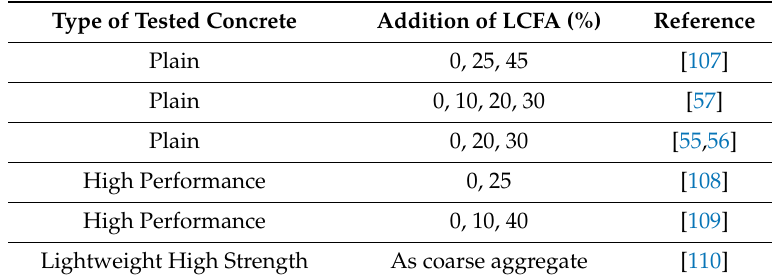
Table 1. Papers which presented test results of the fracture toughness of concretes containing LCFA during Mode I